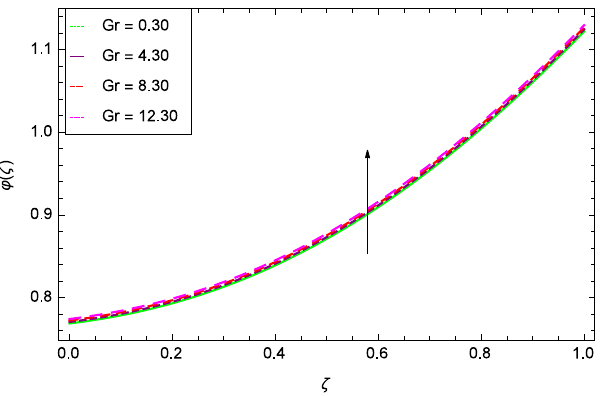
Figure 31. Parameter effect on concentration of homogeneous chemical reactions ϕ ( ζ ) profile.